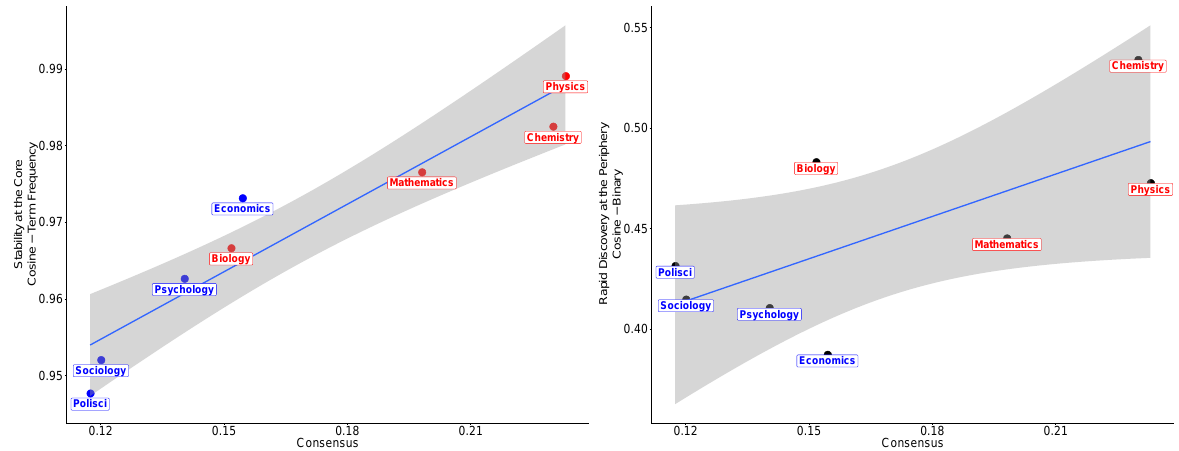
Figure 6: Graphed correlation lines between consensus and each of stability at the core and rapid discovery at the periphery (stability at the core with an R 2 of 0.95 and rapid discovery at the periphery with an R 2 of 0.69). displayed higher consensus, more rapid discovery, and greater stability, while the social sciences exhibited lower consensus, less rapid discovery, and less